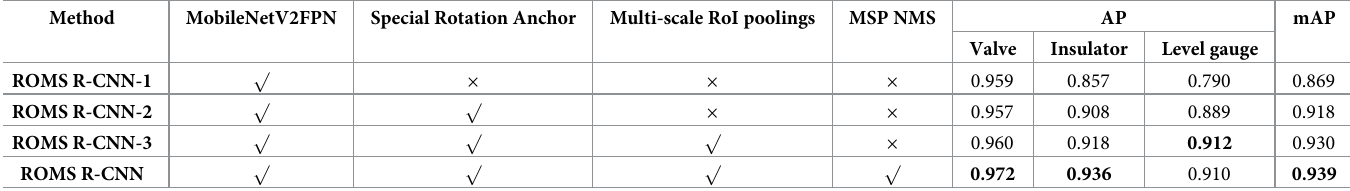
Table 4. mAP comparison of three kinds of industrial equipment detection by ROMS R-CNN algorithm with different structures and functions.